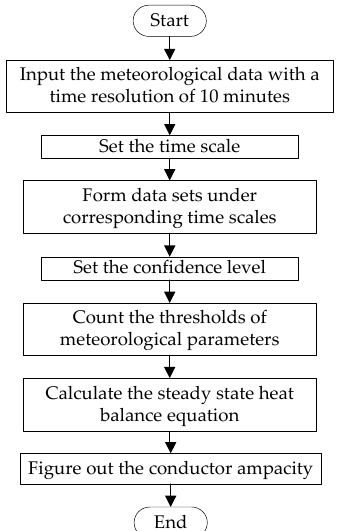
Figure 3. The flow chart of quasi-dynamic thermal rating driven by meteorological data.